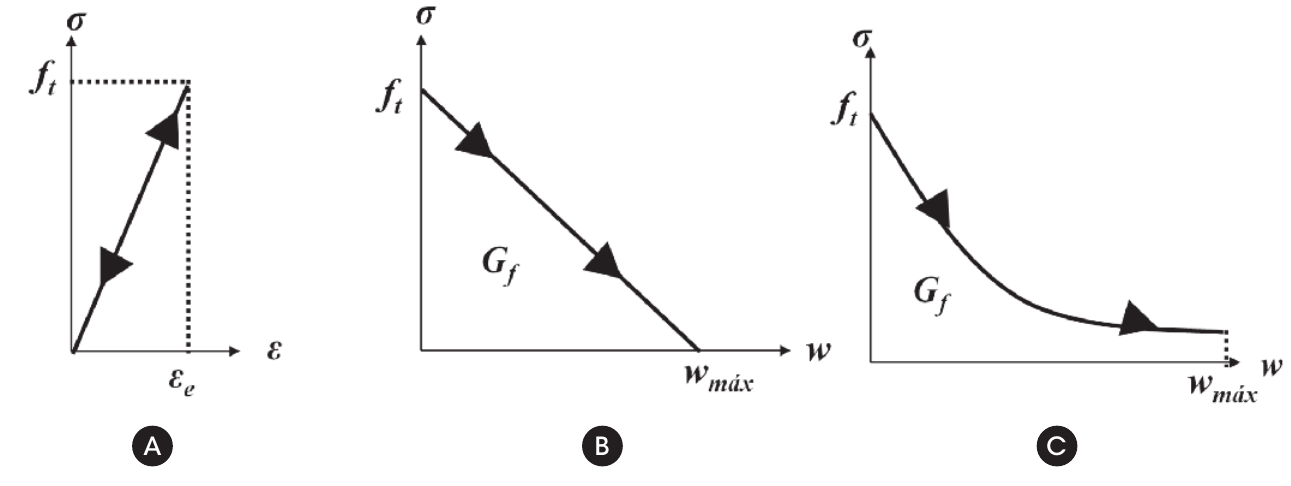
Constitutive relations: a) linear elastic; b) linear softening; c) exponential